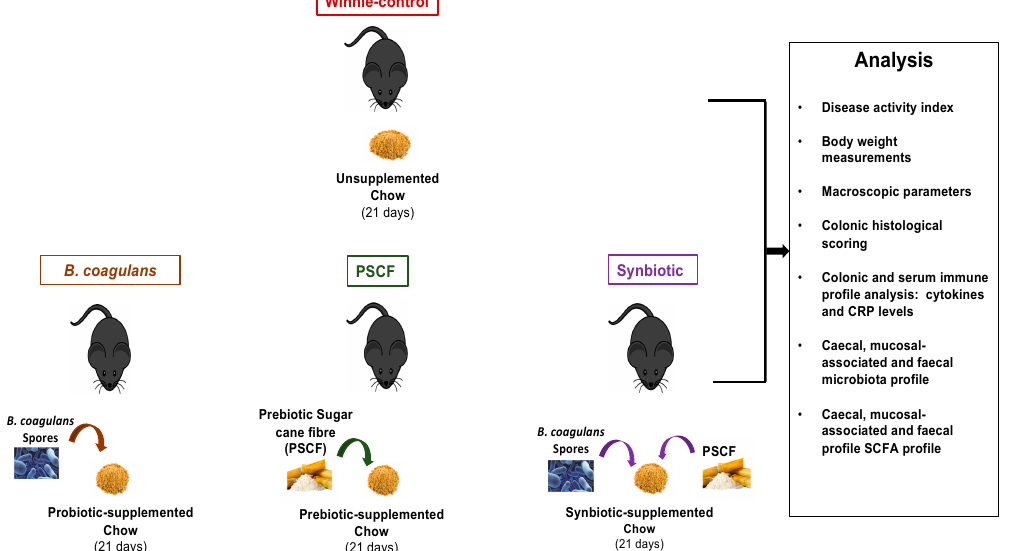
Figure 1. Experimental design of in-vivo feeding trial to analyse therapeutic e ffi cacy of B. coagulans spores, prebiotic sugarcane fibre (PSCF) and Synbiotic in chronic-colitic-Winnie mice. Colitic Winnie mice ( n = 8 per group) that received normal drinking water were fed chow supplemented with either B. coagulans spores, PSCF or their Synbiotic combination for 21 days.